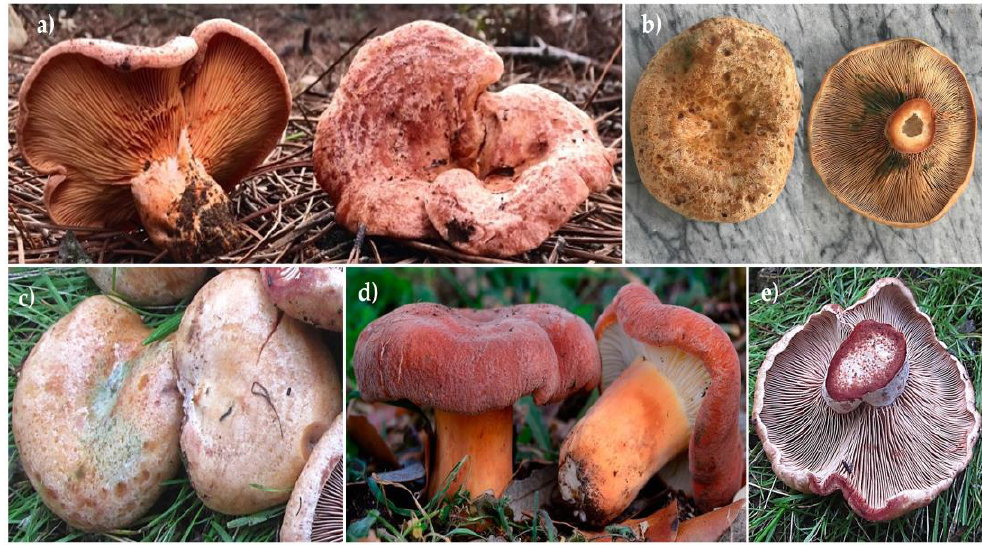
Figure 1. Five wild seasonal species of the genus Lactarius studied: ( a ) L. deliciosus ; ( b ) L. semisanguifluus ; ( c ) L. sanguifluus ; ( d ) L. rugatus ; ( e ) L. vinosus .